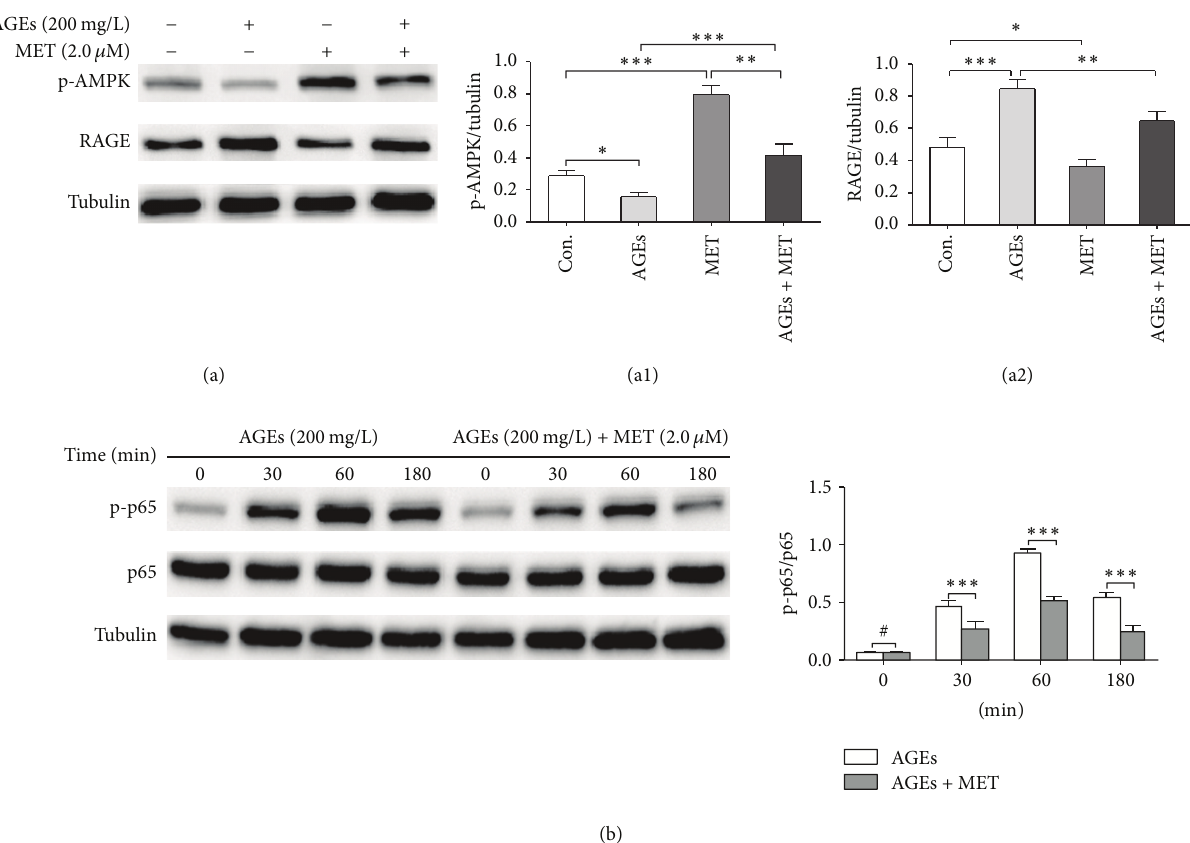
Figure 3: Metformin activates AMPK and inhibits AGEs-induced RAGE expression and NF 𝜅 B activation. (a) BMDMs were divided into 4 groups: control, AGEs, MET, and AGEs + MET group. In AGEs group, cells were cultured with AGEs at 200 mg/L for 24 h; in MET group, cells were cultured with metformin at 2.0 𝜇 M for 24 h; in AGEs + MET group, cells were pretreated with metformin for 60 min and then cultured with AGEs at 200 mg/L for 24 h; in control group, cells were cultured with BSA at 200 mg/L for 24h. Western blot analysis was performed to measure protein levels of RAGE and phosphorylated AMPK (p-AMPK). Tubulin was used as internal control. (b) BMDMs were pretreated with or without metformin (2.0 𝜇 M) for 60min before AGEs (200 mg/L) stimulation for different time intervals (0, 30, 60, and 180 min). Protein levels of NF 𝜅 B-p65 (p65) and phosphorylated NF 𝜅 B-p65 (p-p65) were measured by western blot. Tubulin was used as internal control. Bar graphs represent the results (mean ± SD) of three independent experiments. One-way ANOVA was applied and all the overall ANOVA was significant. # 𝑝 > 0.05 ; ∗ 𝑝 < 0.05 ; ∗∗ 𝑝 < 0.01 ; and ∗∗∗ 𝑝 < 0.001 when compared between selected